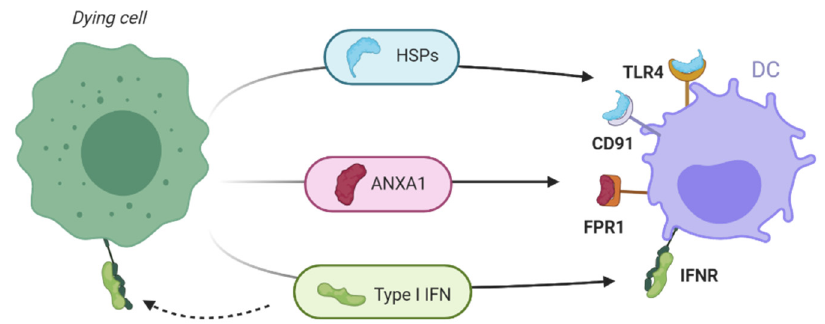
Figure 7. Other DAMPs involved in